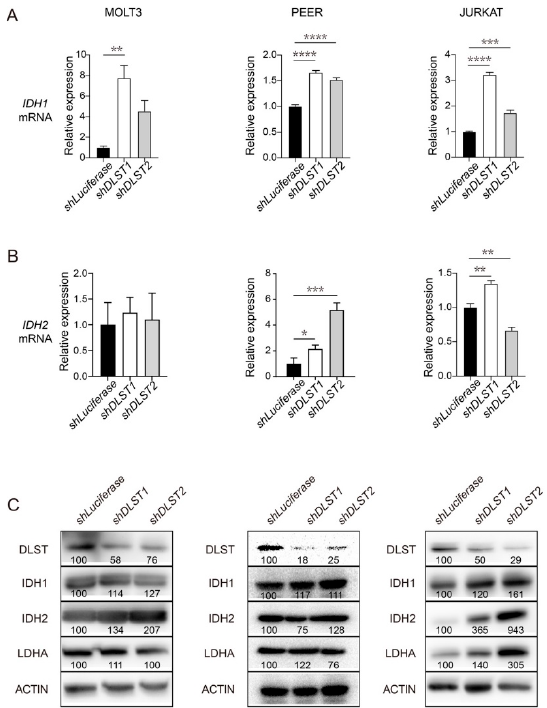
Figure 2. DLST inactivation increases transcript and protein levels of IDH1 and IDH2 in human T- ALL cells. ( A , B ) qRT-PCR analysis of IDH1 ( A ) and IDH2 ( B ) transcript levels at 4 days transduction of shLuciferase and shDLST in human MOLT3, PEER, and JURKAT T-ALL cell lines. Relative fold change was analyzed using the shLuciferase group as a control. The data are presented as the mean ± s.e.m, and statistical differences were calculated using one-way ANOVA. ( C ) Western blotting of DLST, IDH1, IDH2, and LDHA in the same three T-ALL cell lines transduced with shLuciferase or shDLST hairpins. Relative protein to ACTIN ratios are shown at the bottom of each western blotting panel. * p < 0.05, ** p < 0.01, *** p < 0.001, **** p < 0.0001.